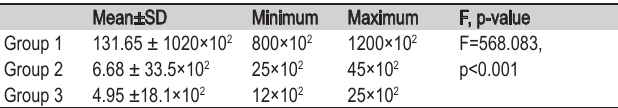
Table 2 - Comparison of the microbial count among the study groups